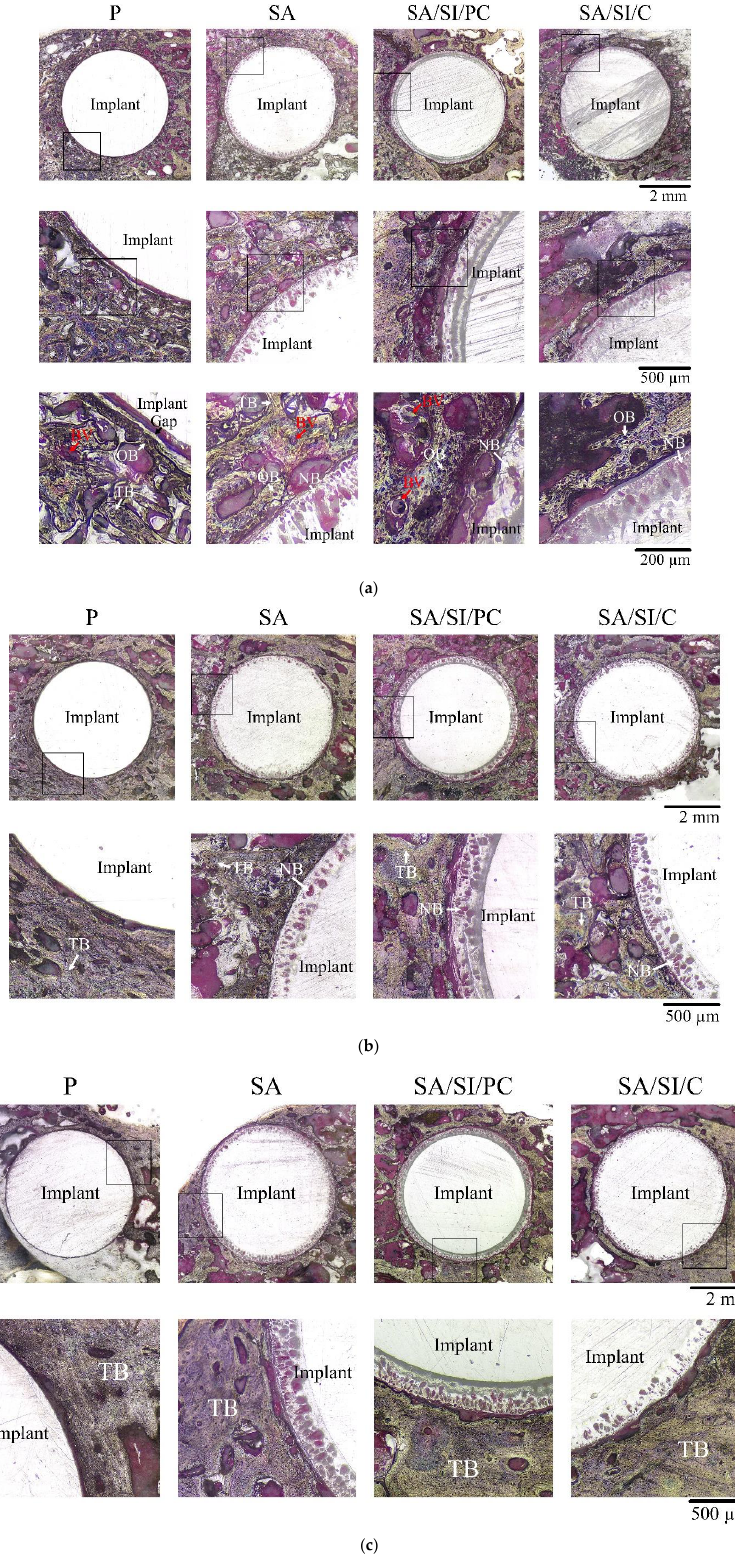
Figure 12. Optimal images of tissue after surface-modified PEEK was implanted into the rabbit distal medial malleolus: ( a ) 4 weeks after implantation, ( b ) 8 weeks after implantation, and ( c ) 12 weeks after implantation (BV: blood vessel, OB: old bone, NB: new bone, and TB: trabecular bone).